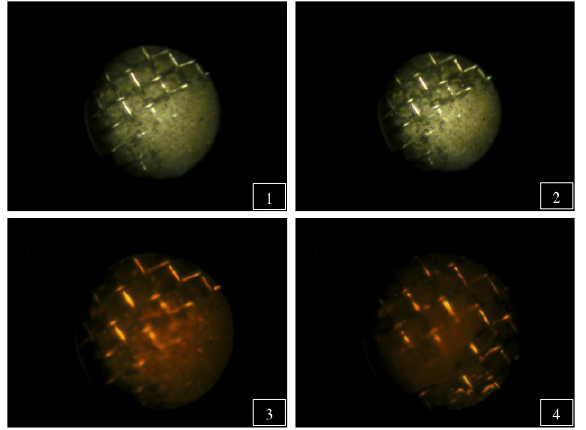
Figure 2. Images made by a boroscope from inside a macropore (experiment 10). Pictures 1 and 2 show a dry macropore. Pictures 3 and 4 show a macropore filled with water (after the application of the twenty-fifth syringe and water started to drain out of the soil column). Note the colour difference between pictures 1 and 2 and 3 and